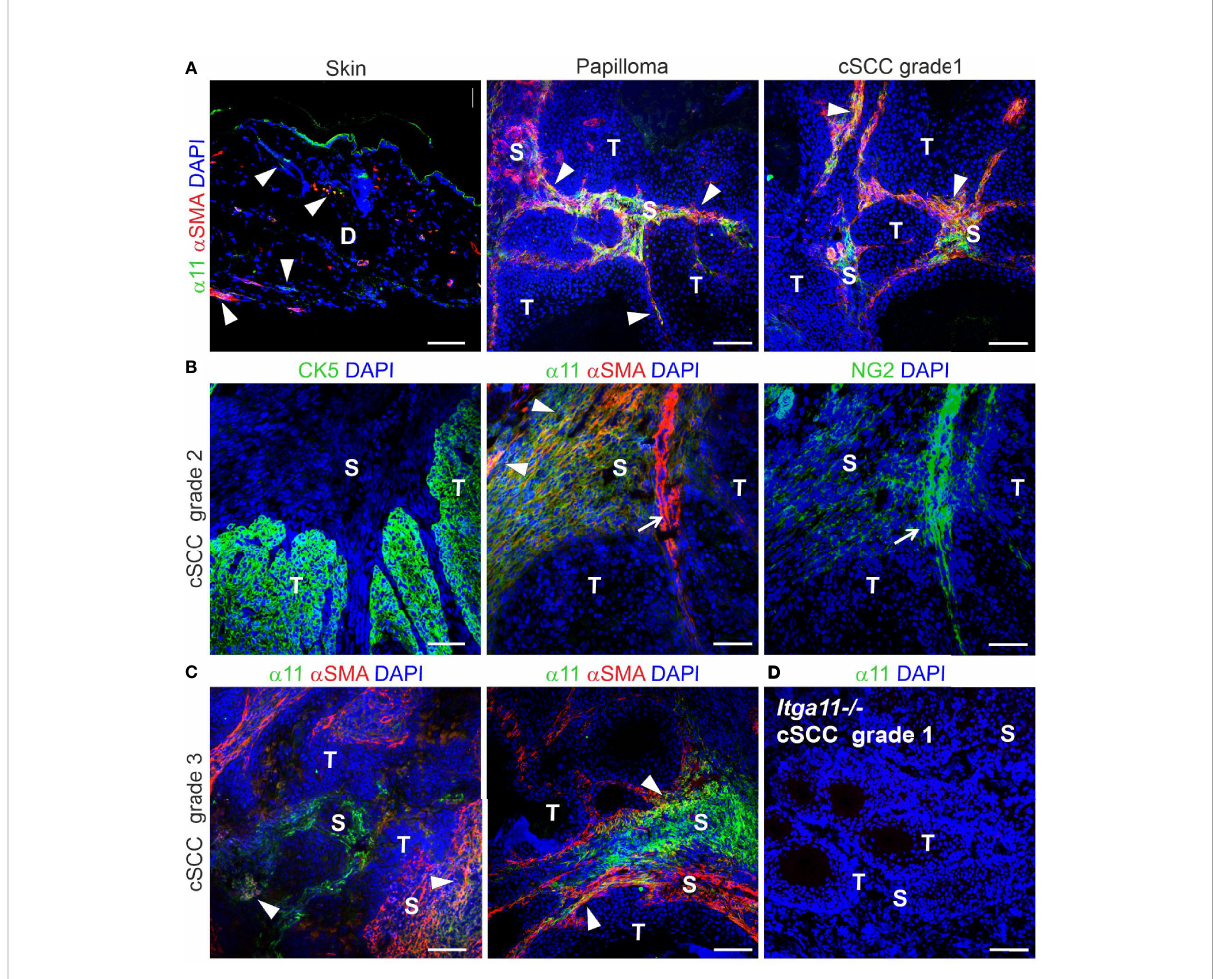
FIGURE 2 Expression and localization of integrin a 11 in mouse skin and chemically induced skin tumors. Representative images of a 11 immuno fl uorescence in normal mouse skin and skin tumors, stained with a polyclonal anti-mouse a 11 antibody (28). (A) a 11 expression is negligible in normal mouse skin; scant positive signals are found around hair follicles and in isolated dermal cells (arrowheads), sometimes overlapping with smooth muscle actin ( a SMA) signals. The positive signal in the corni fi ed epithelium represents non-speci fi c tissue auto fl uorescence due to Alexa Fluor 488-conjugated secondary antibody. (A-C) a 11 is signi fi cantly upregulated in the stroma of premalignant papillomas and malignant cSCCs of different grades and partially co-localizes with a SMA-positive cells (arrowheads). (B) Sequential sections of a moderately differentiated (grade 2) cSCC. Integrin a 11 and a SMA are localized exclusively in the tumor stroma and show partial overlapping (arrowheads). a SMA is also detected in smooth muscle cells around some blood vessels (arrow) and is closely associated with a pericyte marker, NG2. Cytokeratin 5 (CK5) is a marker of carcinoma cells and does not co-localize with a 11. (C) Examples of integrin a 11 and a SMA staining in grade 3 cSCC; immuno fl uorescent signals in the stroma occasionally overlap with a SMA (arrowheads). (D) A well differentiated (grade 1) cSCC from a Itga11 -/- mouse was used as a staining control for the a 11 antibody. Scale bars: A, 100 m m, B-D, 50 m m. Markings in images: D, dermis; S, stroma; T,